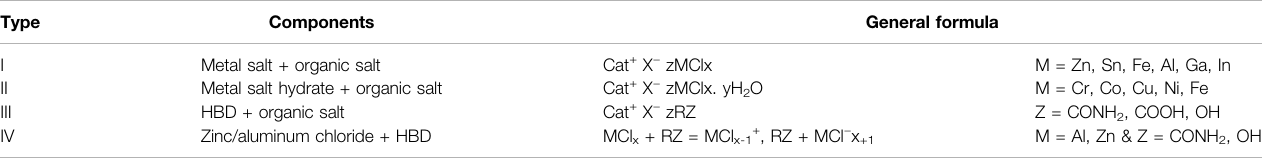
TABLE 3 | General formula for the classi fi cation of DESs (Satlewal et al., 2018). Type